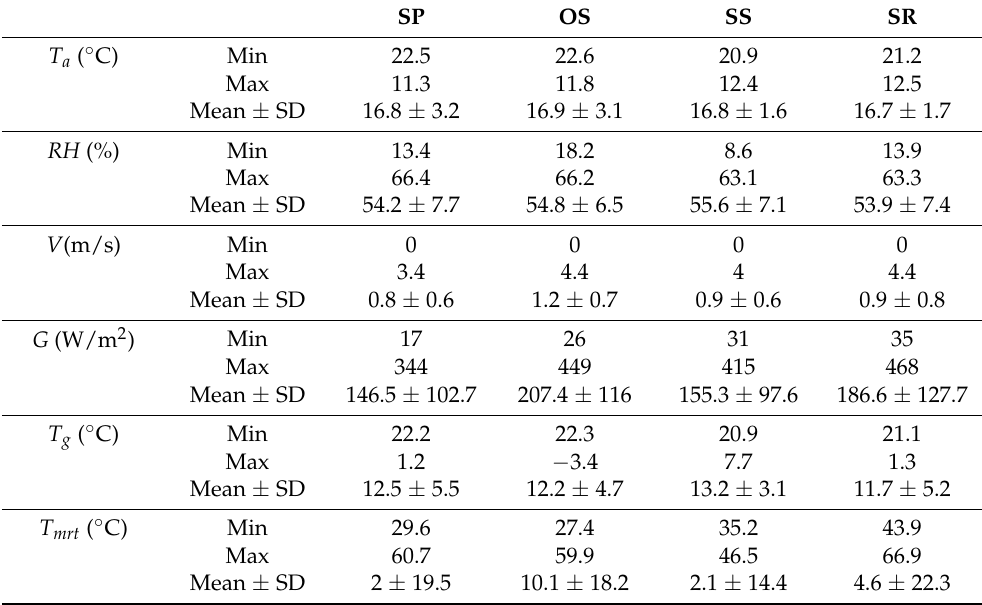
Table 4. Measurements of meteorological variables among sites.